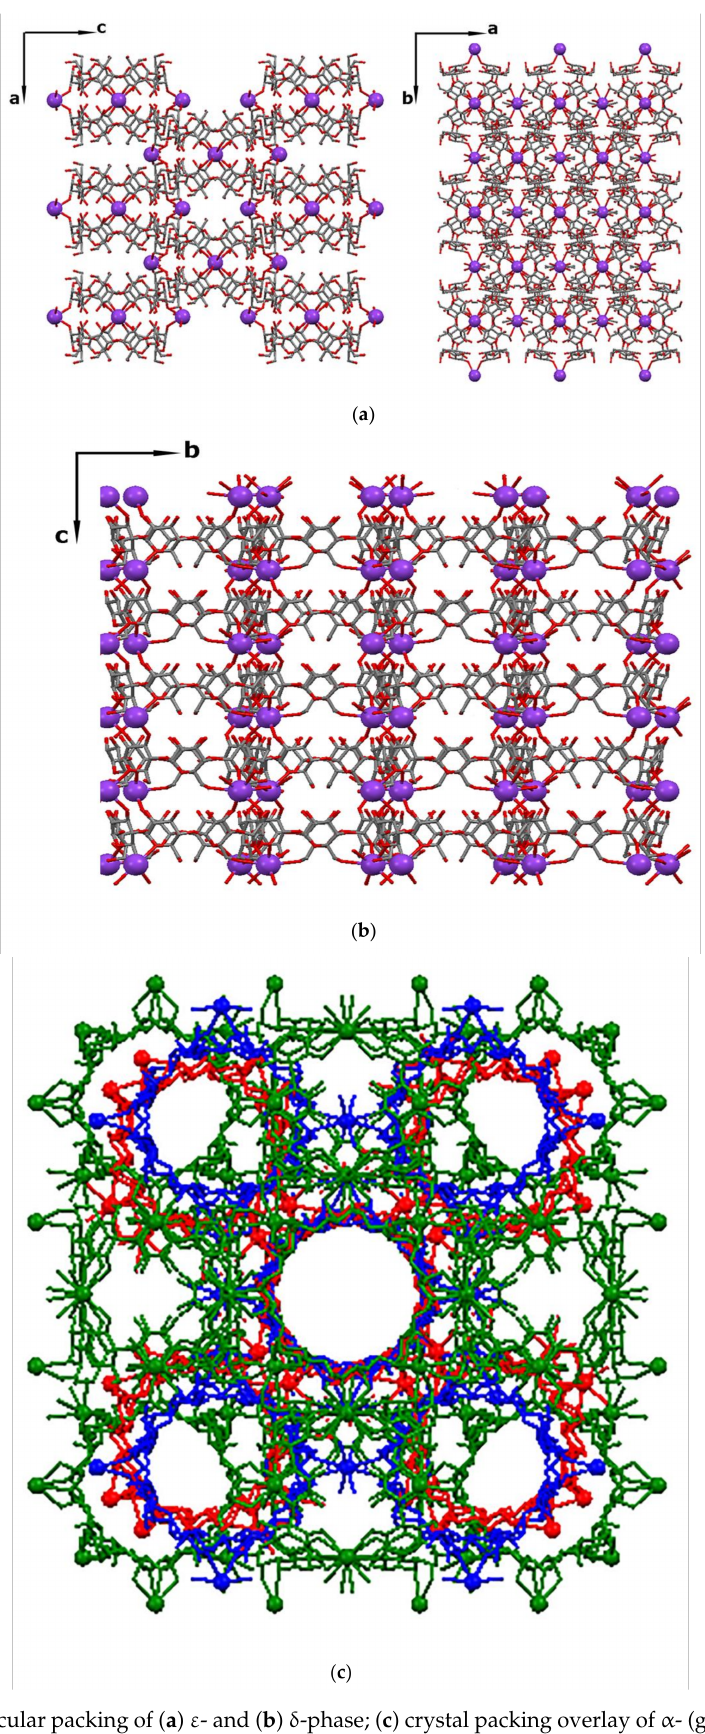
Figure 4. Molecular packing of ( a ) ε - and ( b ) δ -phase; ( c ) crystal packing overlay of α - (green), δ - (blue), and ε - (red) phases. Hydrogen atoms are omitted for